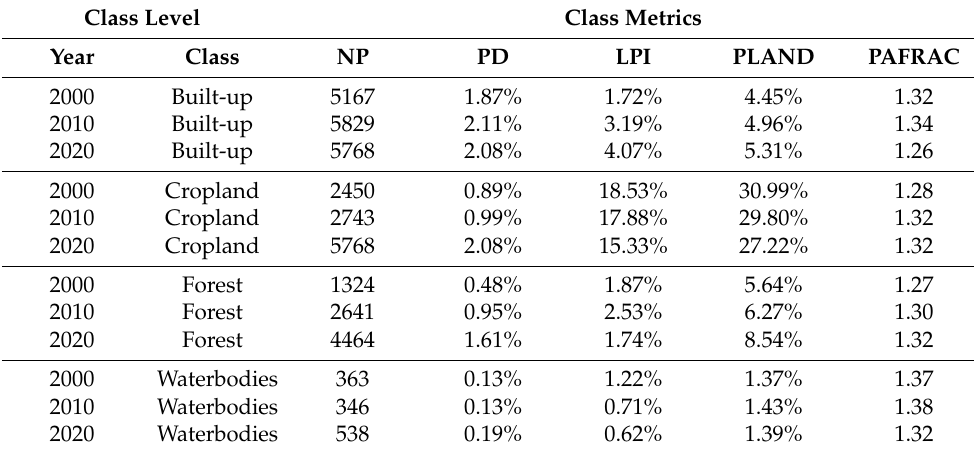
Table 6. Landscape pattern changes at the class level in Pyongyang, North